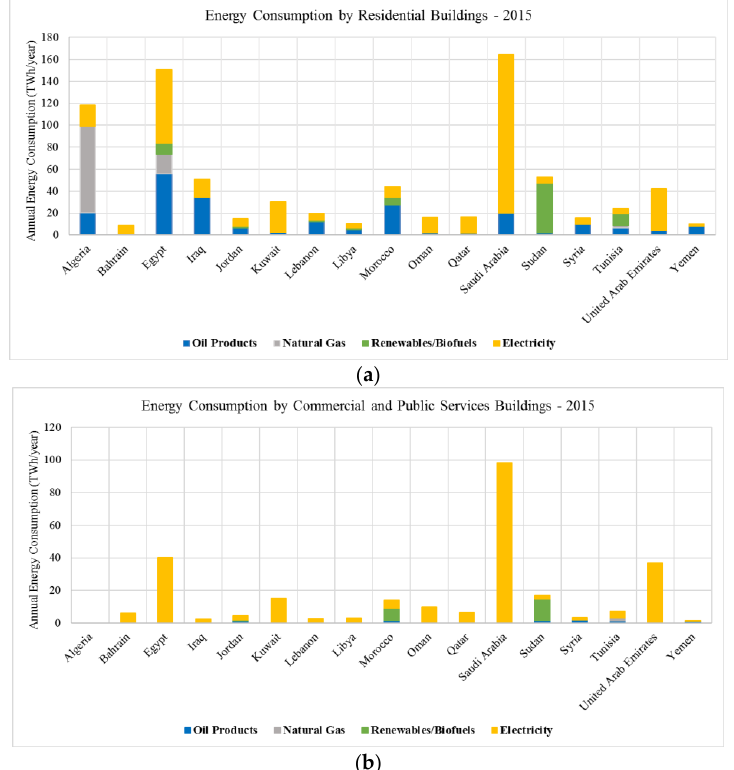
Figure 12. Total final consumption by energy sources for ( a ) residential and ( b ) non-residential (i.e., commercial and public) buildings for most Arab countries during